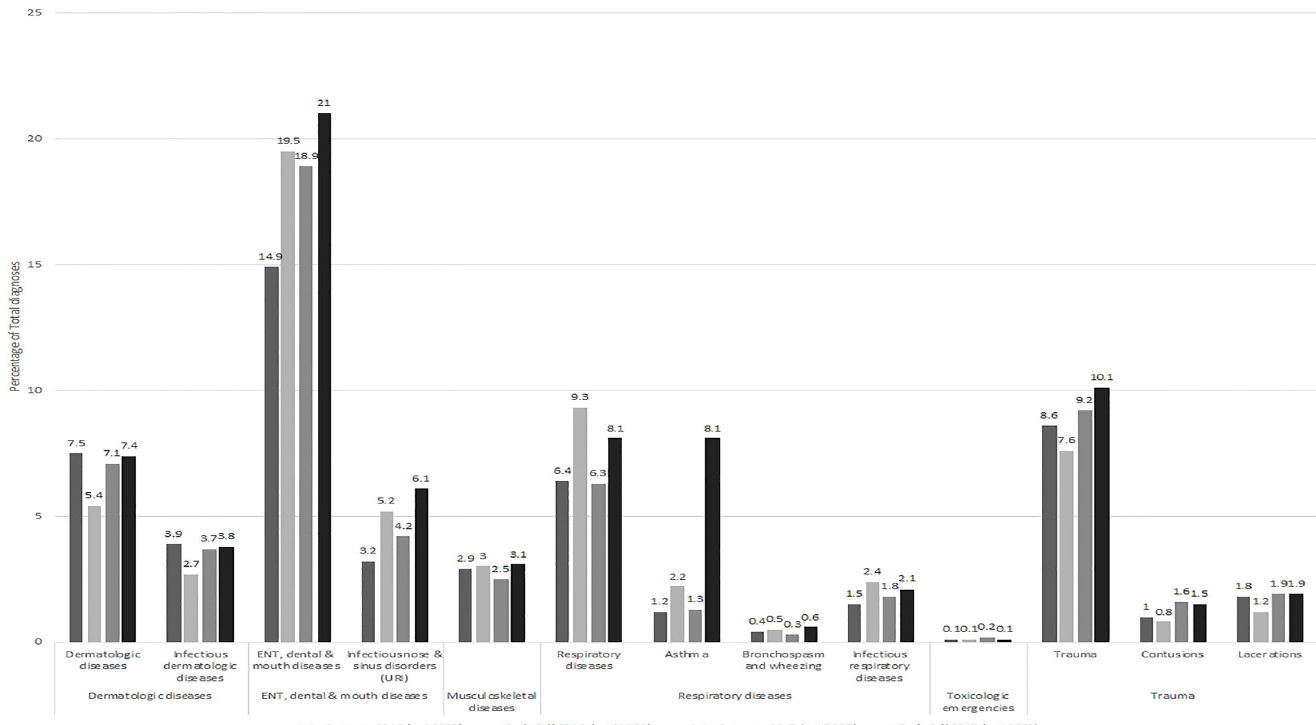
Figure. Emergency department diagnosis groups by year, before and after Hurricane Harvey which made landfall on August 25,